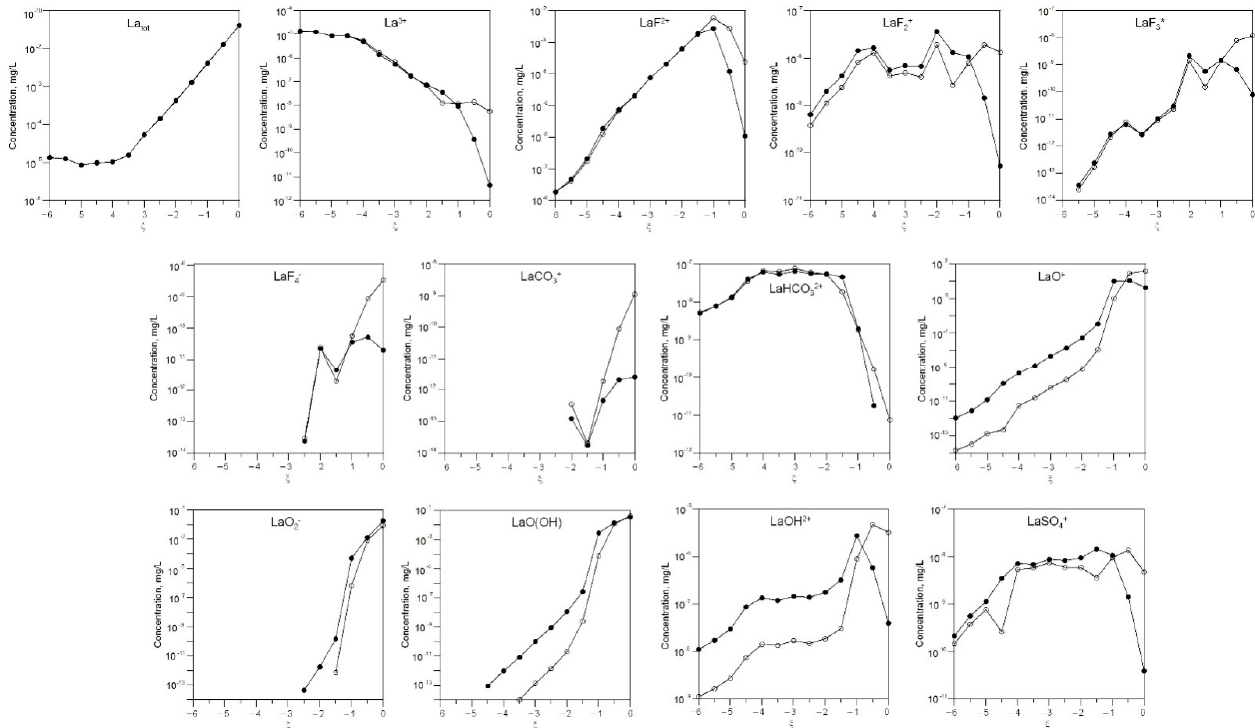
Figure 2. Change in the concentrations of dissolved lanthanum depending on ξ at 3 ◦ C (white) and 20 ◦ C (black). As can be seen, the gross concentrations of lanthanum and cerium are the same at 3 ◦ C and 20 ◦